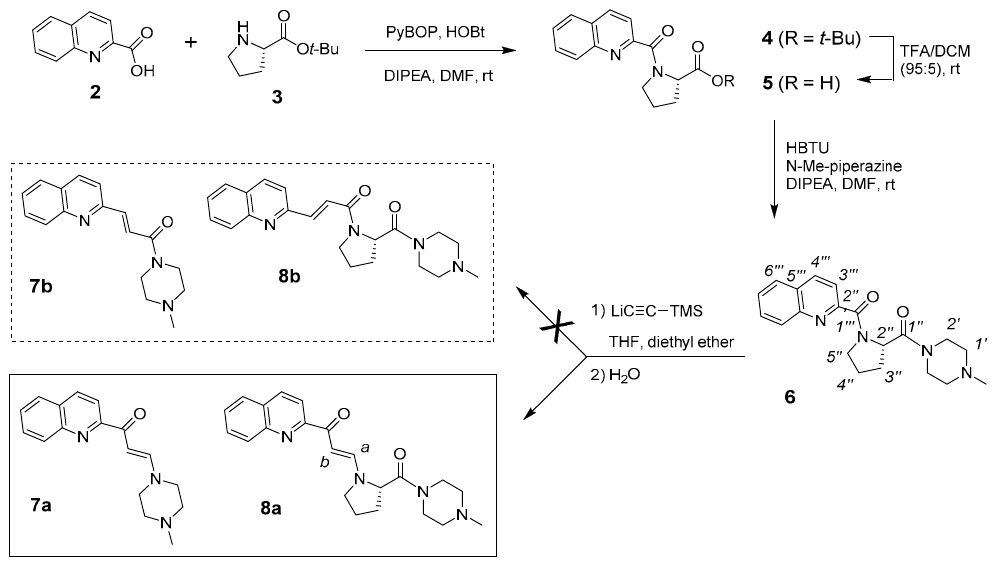
Figure 2. Synthesis of model side chain (compound 6 ) and two rearranged side chains (compounds 7a and 8a ) resulting from the ethynylation reaction.